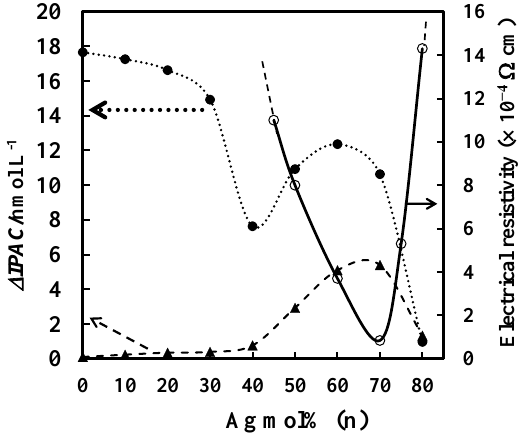
Figure 8. Electrical resistivity and dependency of net photoreactivity (∆IPAC) of each thin film as a function of Ag mol% in the Ag/TiO composite thin films. The lines indicate as 2 follows: open circle, resistivity; close circle  IPAC under UV; filled triangle ∆IPAC under Vis. These values (∆IPAC) were obtained to measure the differences between the IPAC